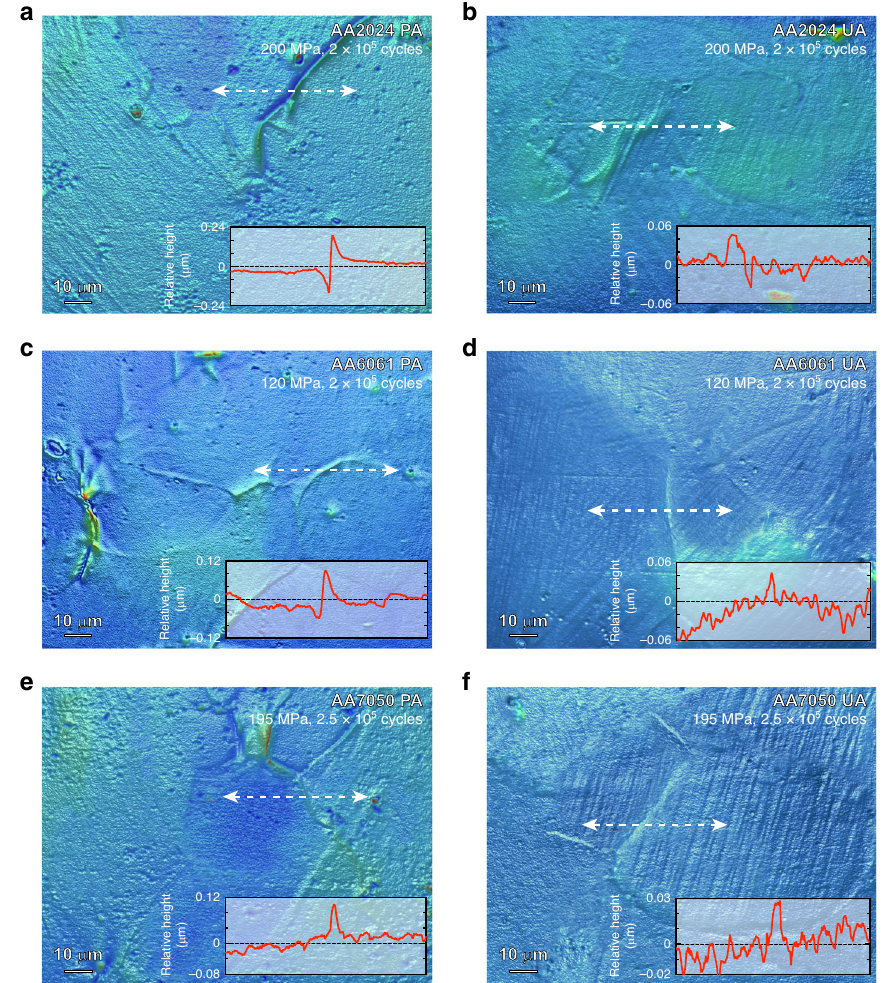
Fig. 3 Surface evolution of air quenched (AQ) AA2024, AA7050, and AA6061 alloys with obvious precipitate-free zones (PFZ ’ s). a , c , e The large localized surface relief along the grain boundaries for the peak aged (PA) alloys after certain number of high cycle fatigue (HCF). b , d , f The uniform surface relief formed through the grains for the under aged (UA) alloys after certain number of high cycle fatigue (HCF). The red curves show the relative height of different surface relief highlighted by white